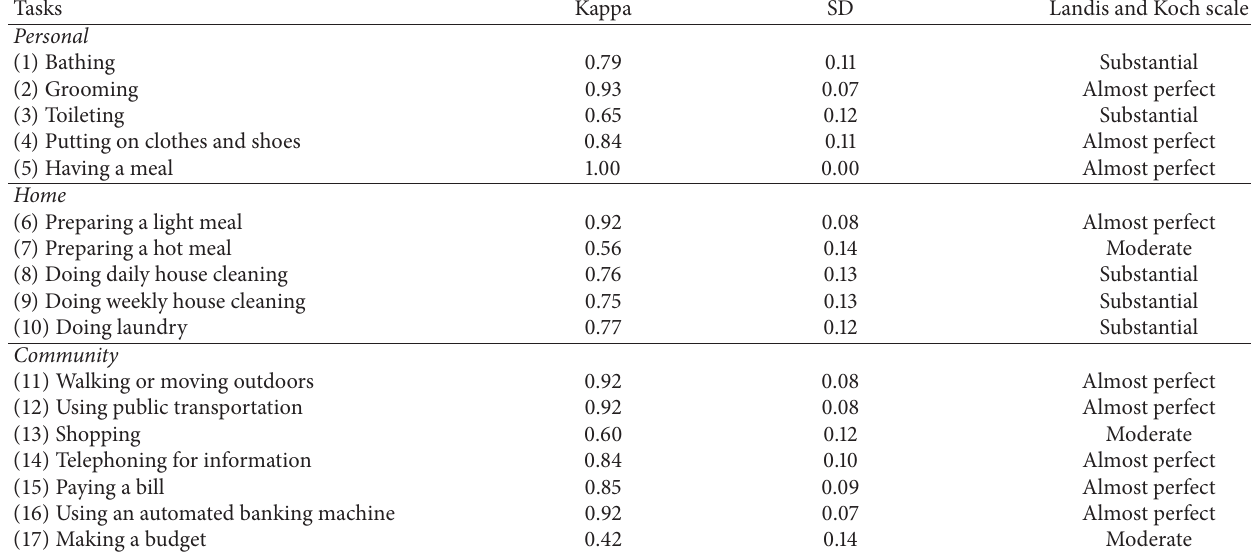
Table 3: Test-retest reliability of the operation of planning of the ADL